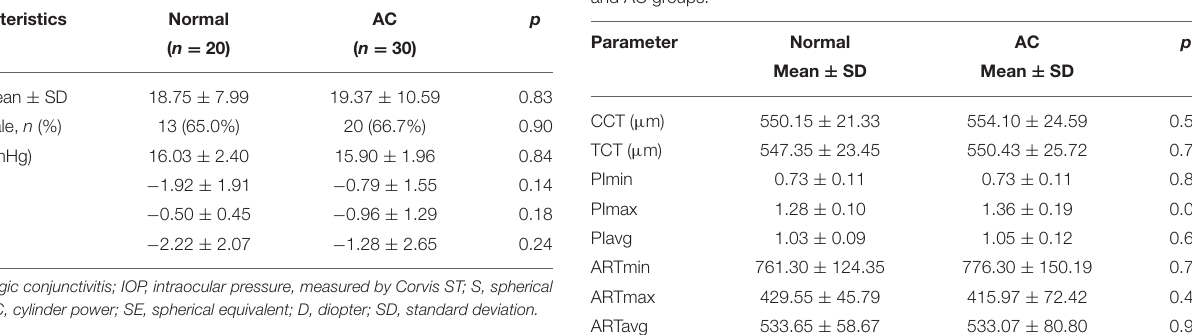
TABLE 3 | Comparison of corneal pachymetric parameters between the normal and AC groups. Parameter Normal